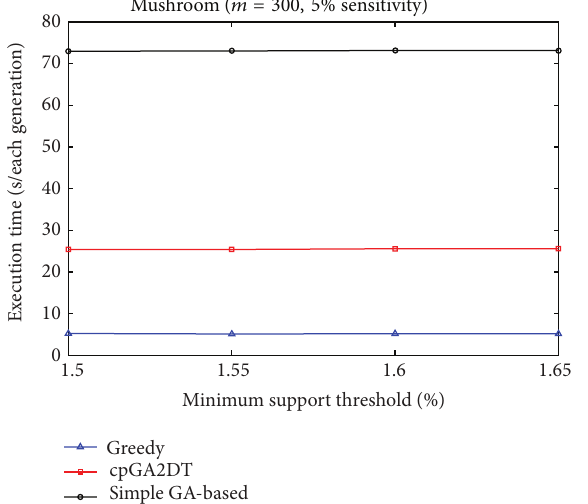
Figure 12: Comparisons of execution time at various minimum support thresholds for BMSWebview-2